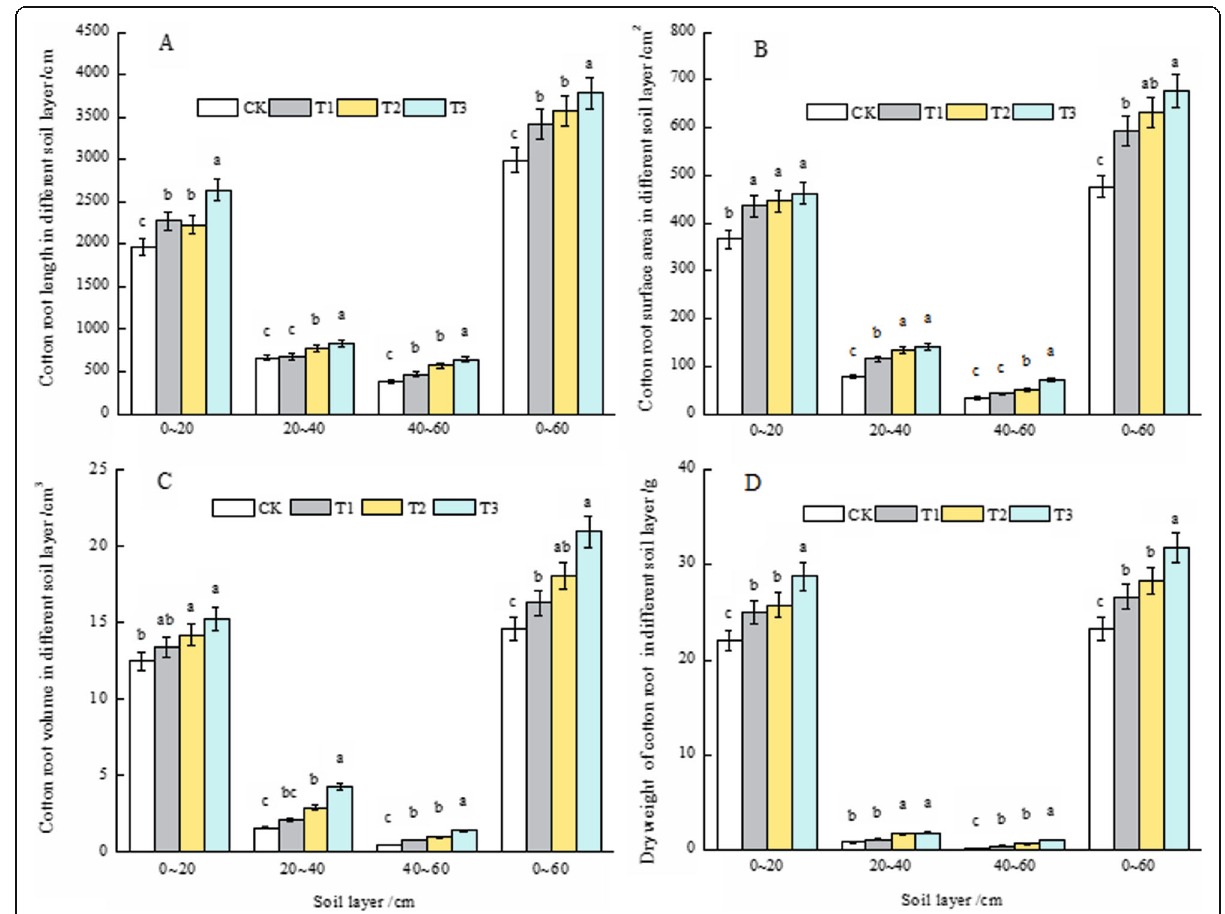
Fig. 8 Changes in cotton root characteristics in different soil layers in different treatments in